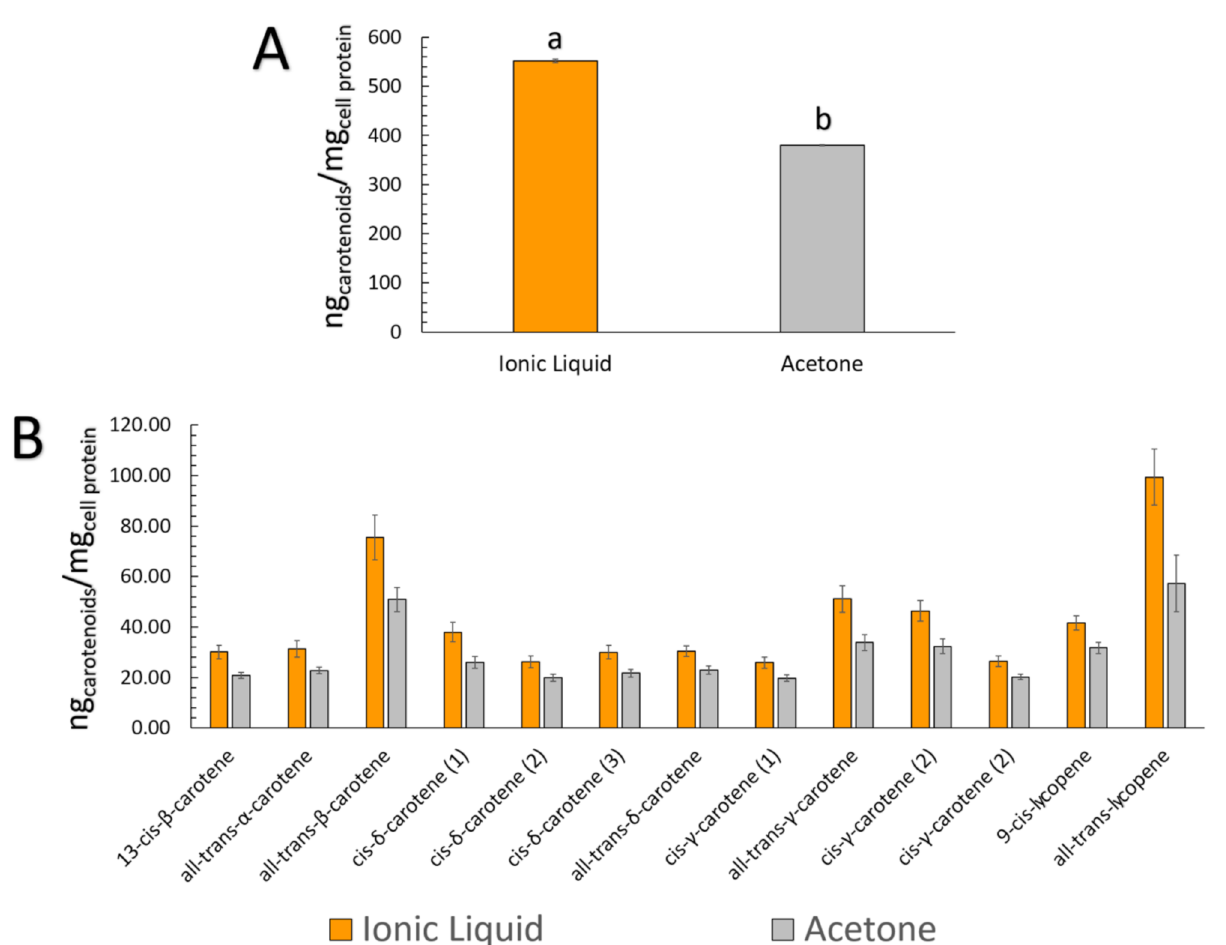
Figure 6. Carotenoid uptake by Caco-2 cells (ng carotenoids /mg cell protein ). Data are related to the ng of carotenoids that were taken from the micellar fraction after 4 h of exposure. ( A ) Total carotenoids uptake from each extract—Different letters above each bar correspond to a significant difference between the [C 4 mim][BF 4 ] and acetone extracts ( t -test and Dunn test for mean comparisons were carried out); ( B ) Carotenoids uptake from each compound present in the